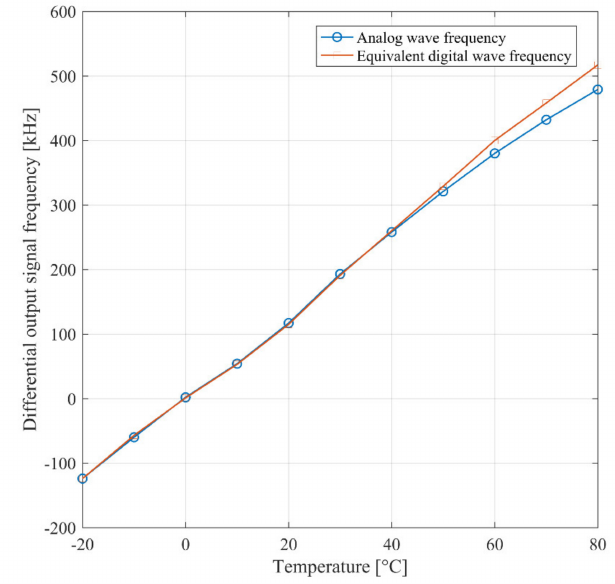
Figure 13. Measured Schmitt trigger output signal frequency versus temperature.